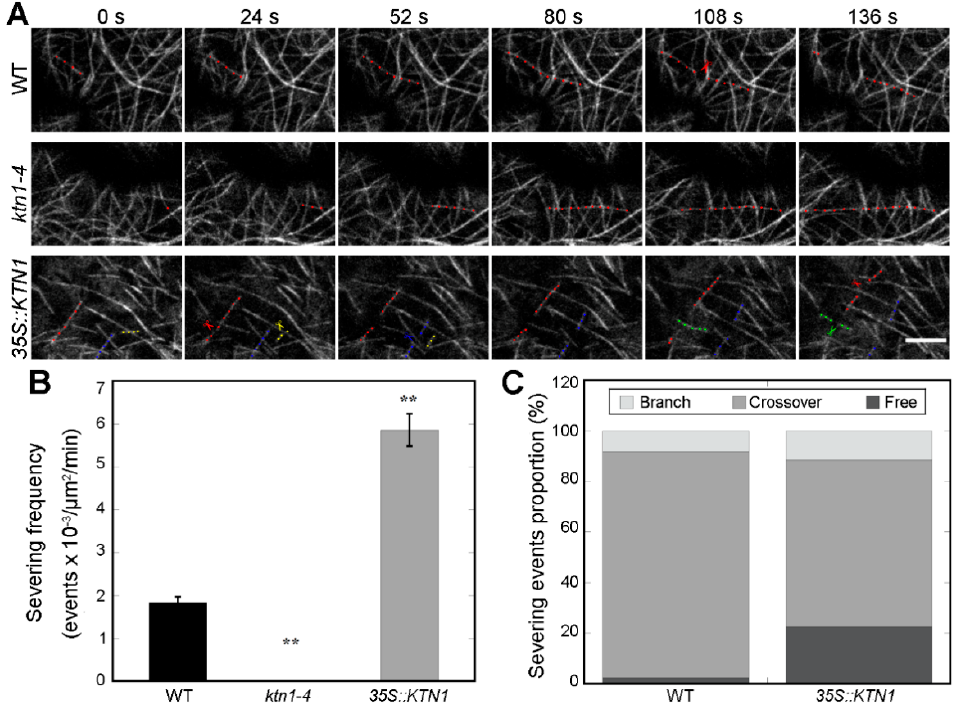
Figure 5. Time-lapse imaging of microtubules revealed abnormal severing frequencies in both ktn1-4 and 35S::KTN1 cotyledon pavement cells. ( A ) Time-lapse images showing microtubule severing events in WT (Col-0), ktn1-4 and 35S::KTN1 cells. The images presented is an optical section. A filament highlighted with colored dots underwent severing, and the corresponding colored scissors indicate the severing events. Di ff erent colors (red, blue, green and yellow) indicated di ff erent filaments. See Supplemental Movie 1-3 online for the entire series. Scale bar = 5 µ m. ( B ) Quantitative comparison of severing frequencies in microtubules of WT (Col-0), ktn1-4 and 35S::KTN1 cells (n = 6 cells for each genotype). Error bars indicate SE. ** P < 0.01 by a Student’s t test. ( C ) Quantification of the proportions of severing events (severed at branched sites, microtubule crossovers or at free microtubules) of cortical microtubules in WT (Col-0), ktn1-4 and 35S::KTN1